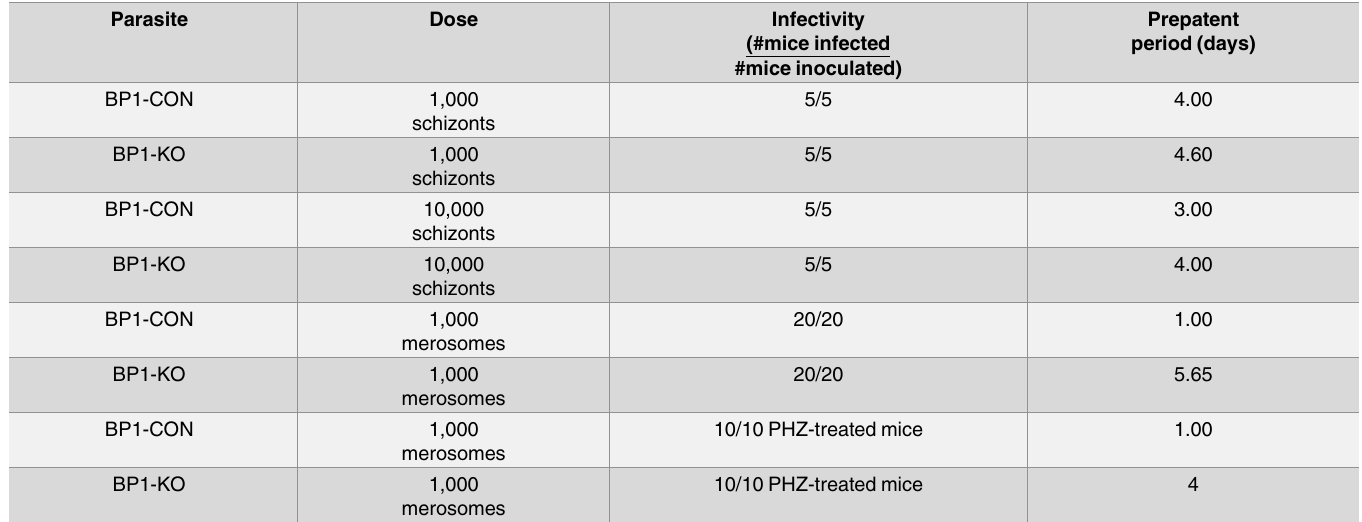
Table 2. Liver and blood stage merozoite infectivity of berghepain-1 knockout parasites. Swiss Webster mice were injectedi.v. with purifiedblood stage schizonts or merosomesof BP1-CON and BP1-KO clone 1 parasites and parasitemia was monitored daily. In the last set of experiments, mice were pre-treatedwith phenylhydrazine (PHZ) prior to inoculationof BP1-CON and BP1-KO